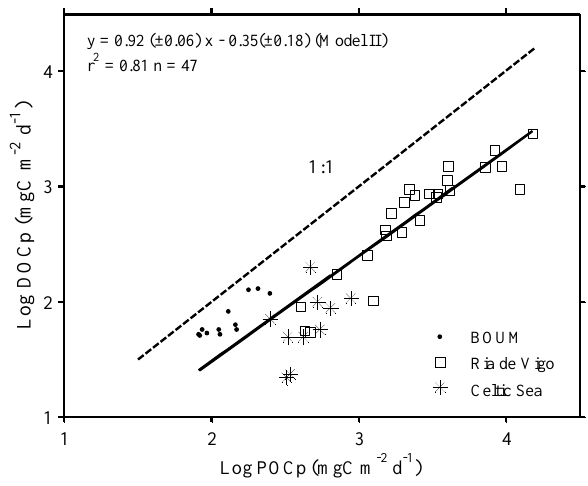
Figure 6. Relationship between particulate (POCp) and dissolved organic carbon production (DOCp) with vertically integrated data from different ecosystems: The Mediterranean Sea (BOUM cruise, this study), NW Iberian Peninsula (Marañón et al. 2004), and the Celtic Sea (Marañón et al. 2005). The slope of the regression line for the overall dataset was not significanlty different from 1 (Clarke test, P = 0.177).